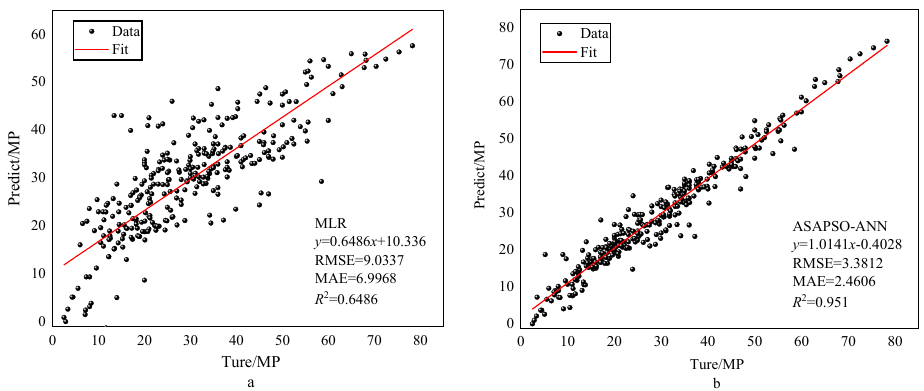
Table 5. Metrics for MLR and ASAPSO-ANN models.